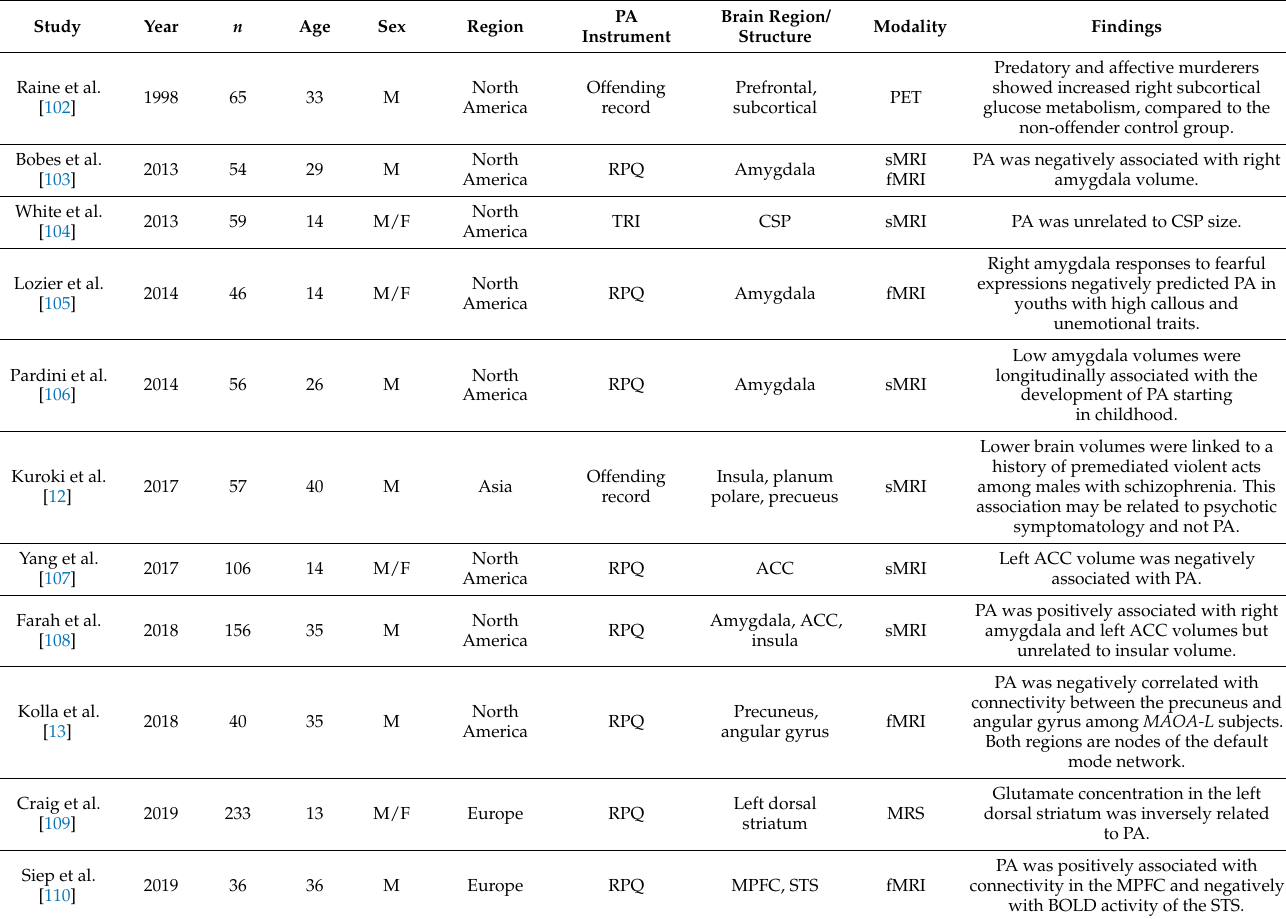
Table 6. Proactive aggression neuroimaging findings according to year of